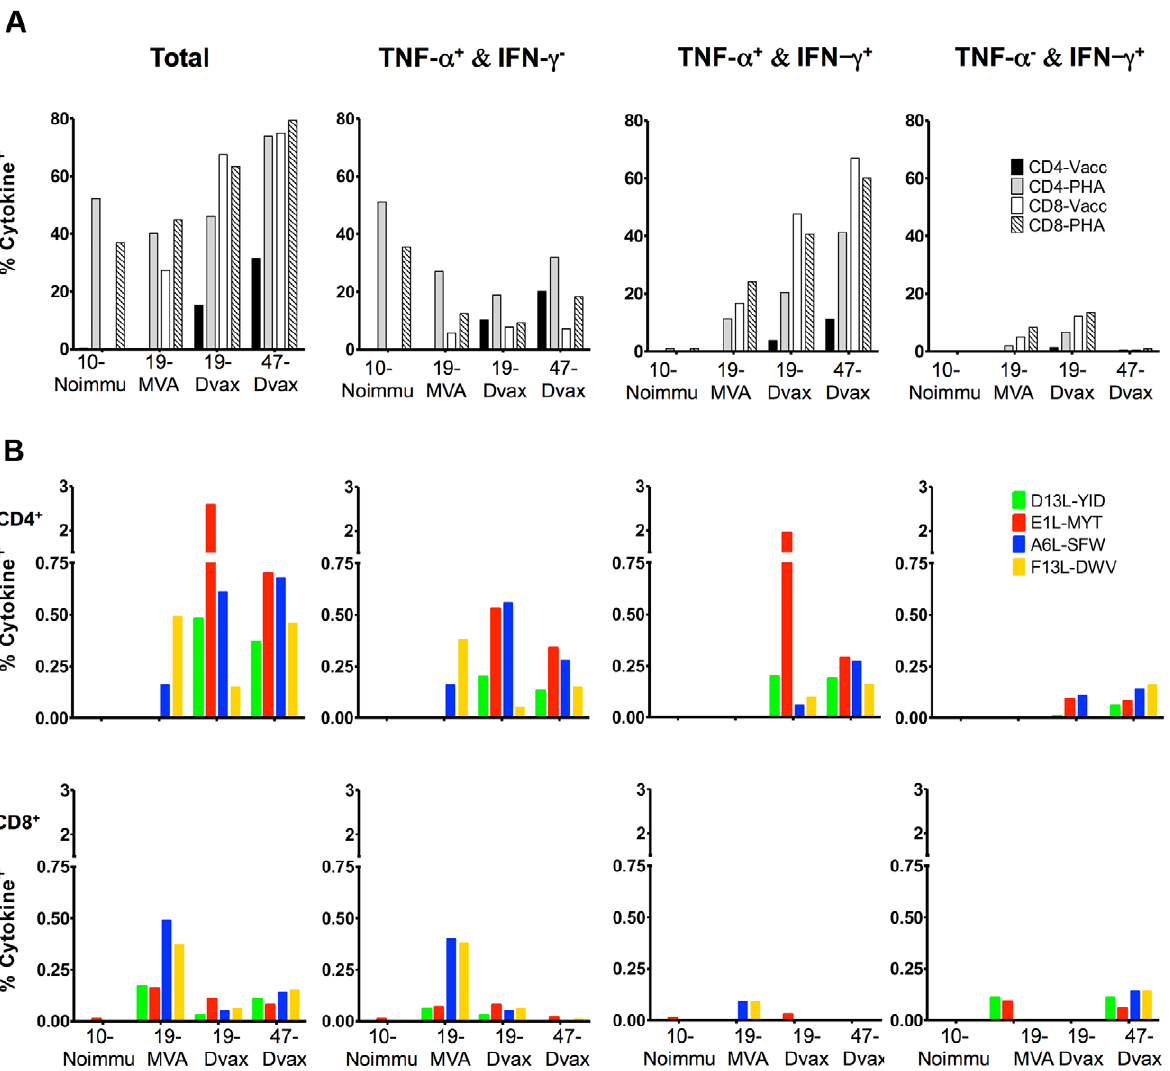
Figure 9. Intracellular cytokine production by vaccinia specific T cell lines. Vaccinia T cells lines were generated with PBMCs from vaccinated donors VRC19 and VRC47, and from unvaccinated donor TPI10 as detailed in the Material and Methods section. T cell lines were evaluated for their recognition of vaccinia virus and the vaccinia peptides by intracellular TNF- a and IFN- c production. Data represent the percentage of CD4 + or CD8 + T cells in each line producing either of the four possible combination of cytokines in response to vaccinia infected autologous LCL and PHA (A) or to the identified vaccinia peptides (10 m g/ml) (B).